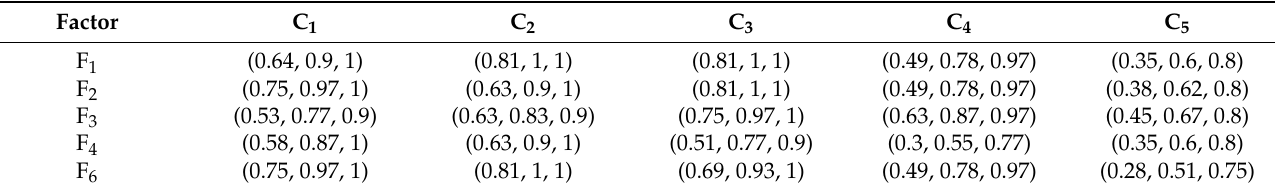
Table 20. The fuzzy weighted normalized decision